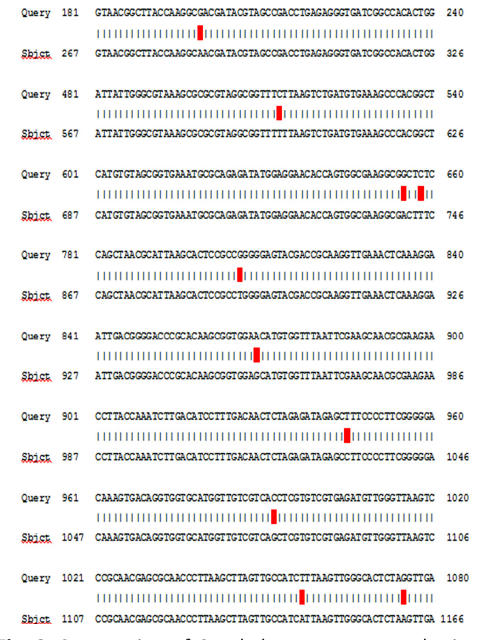
Fig. 3. Neighbor-joining tree Staphylococcus aureus of 16S rRNA